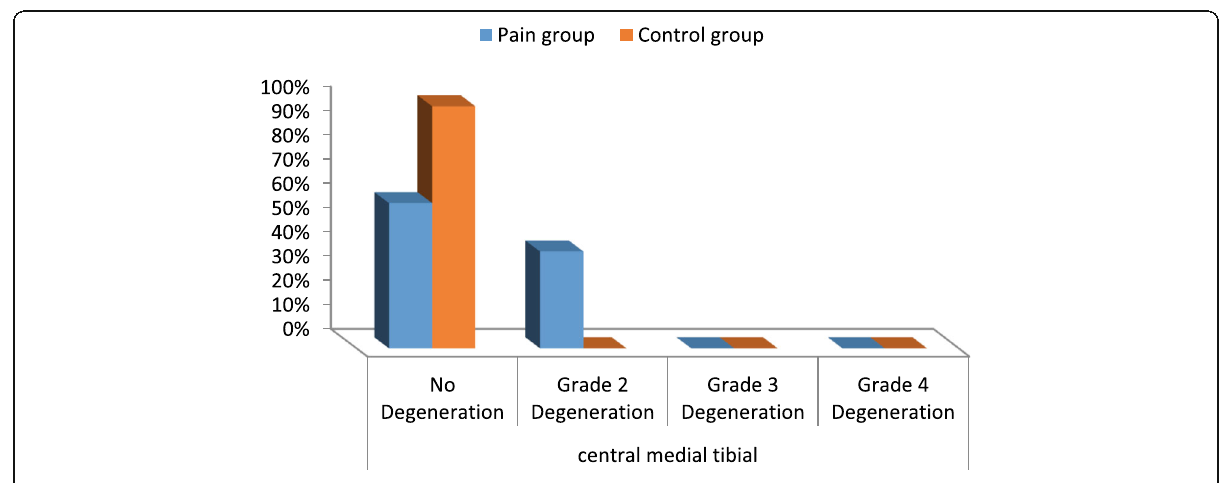
Fig. 8 Distribution of central medial tibial degeneration according to ICRS degeneration